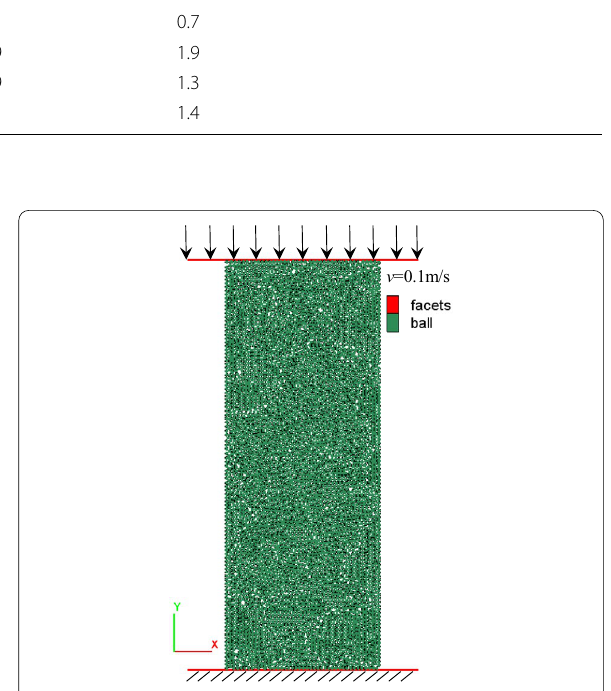
Fig. 9 Numerical simulation of the UCS